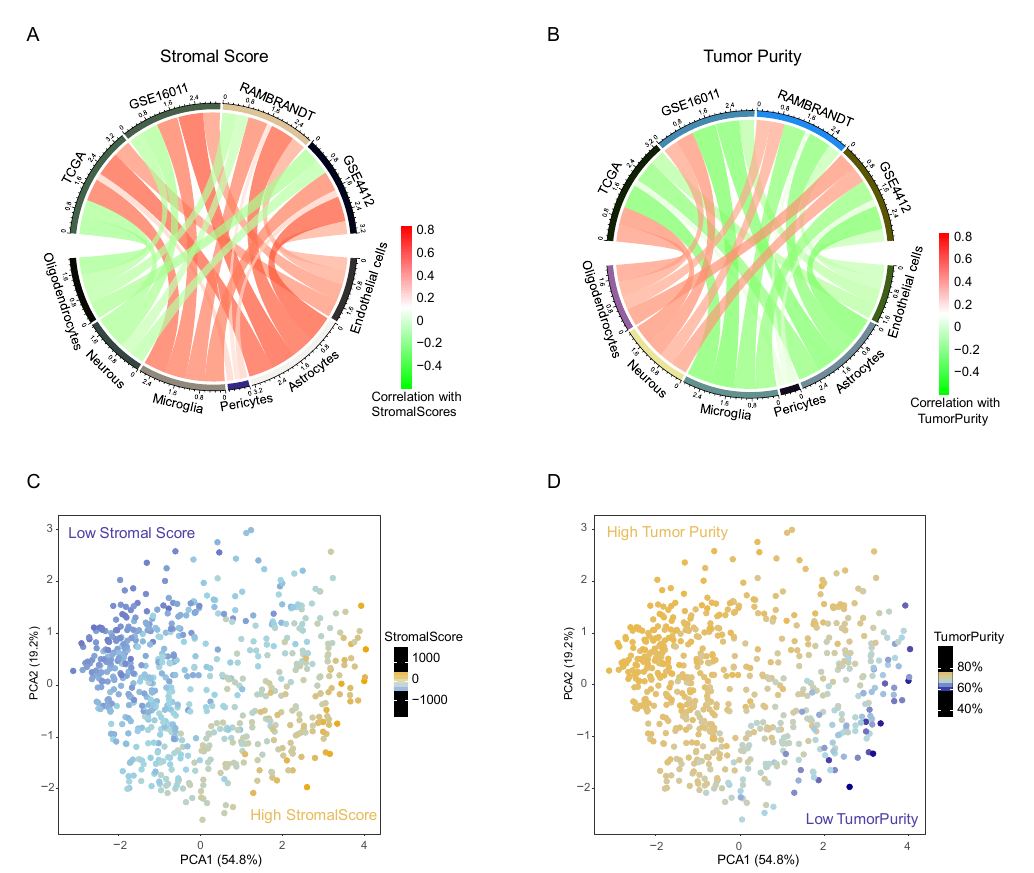
Figure 1. The remarkable but distinct correlations between the infiltration of six kinds of stromal cells with stromal scores ( A ) or tumor purity ( B ). Red represents a positive correlation, and green represents a negative correlation among all cohorts. PCA revealed that the GSVA scores of stromal cells could distinguish the numerical value of stromal scores ( C ) or tumor purity ( D ).